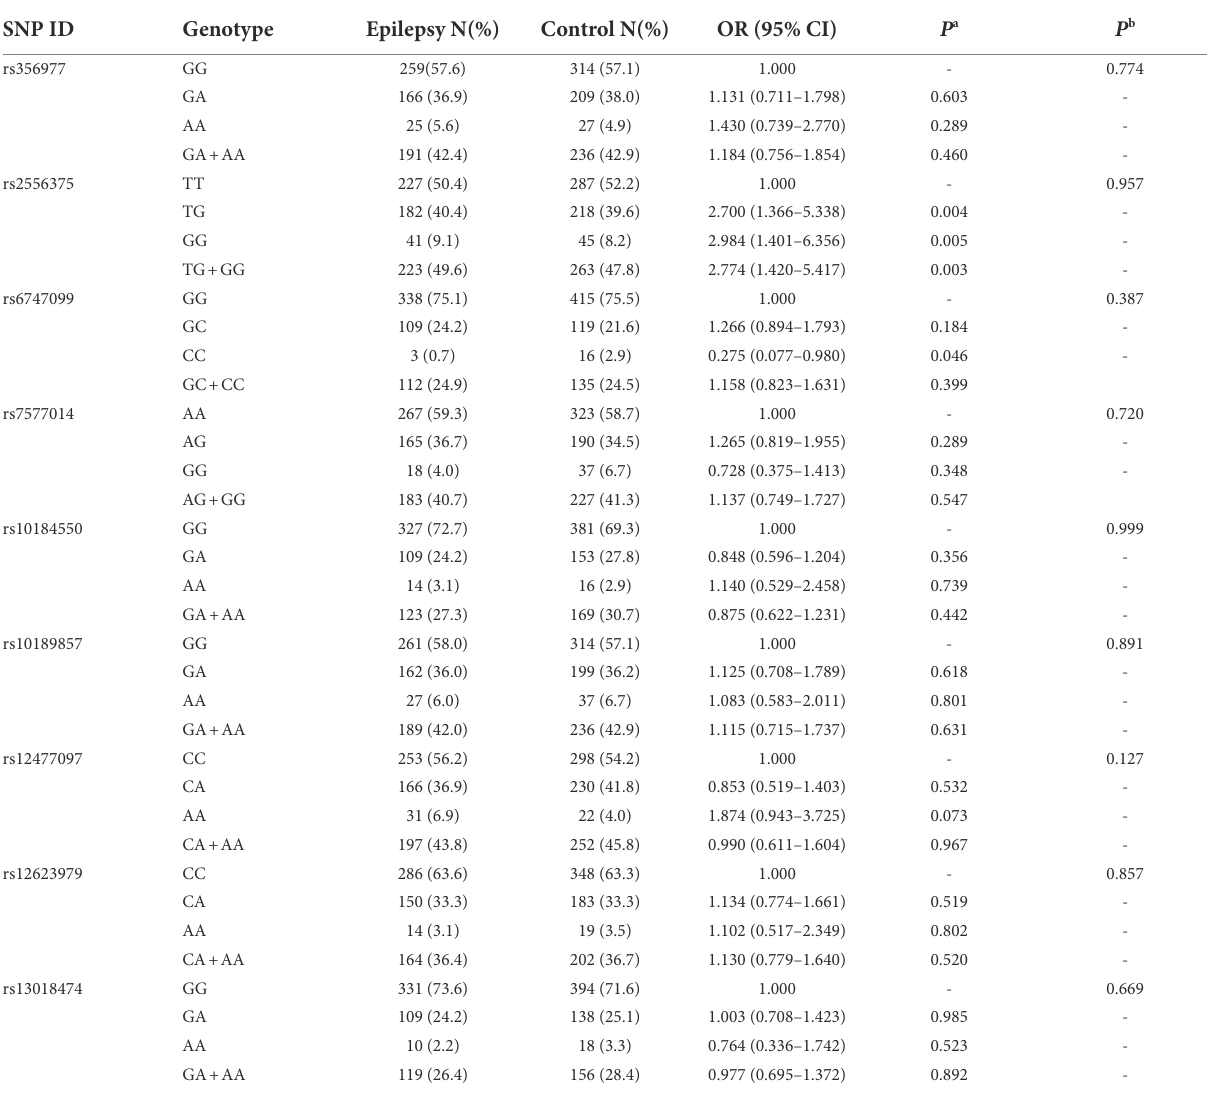
TABLE 2 Associations between BCL11A SNP genotypes and epilepsy